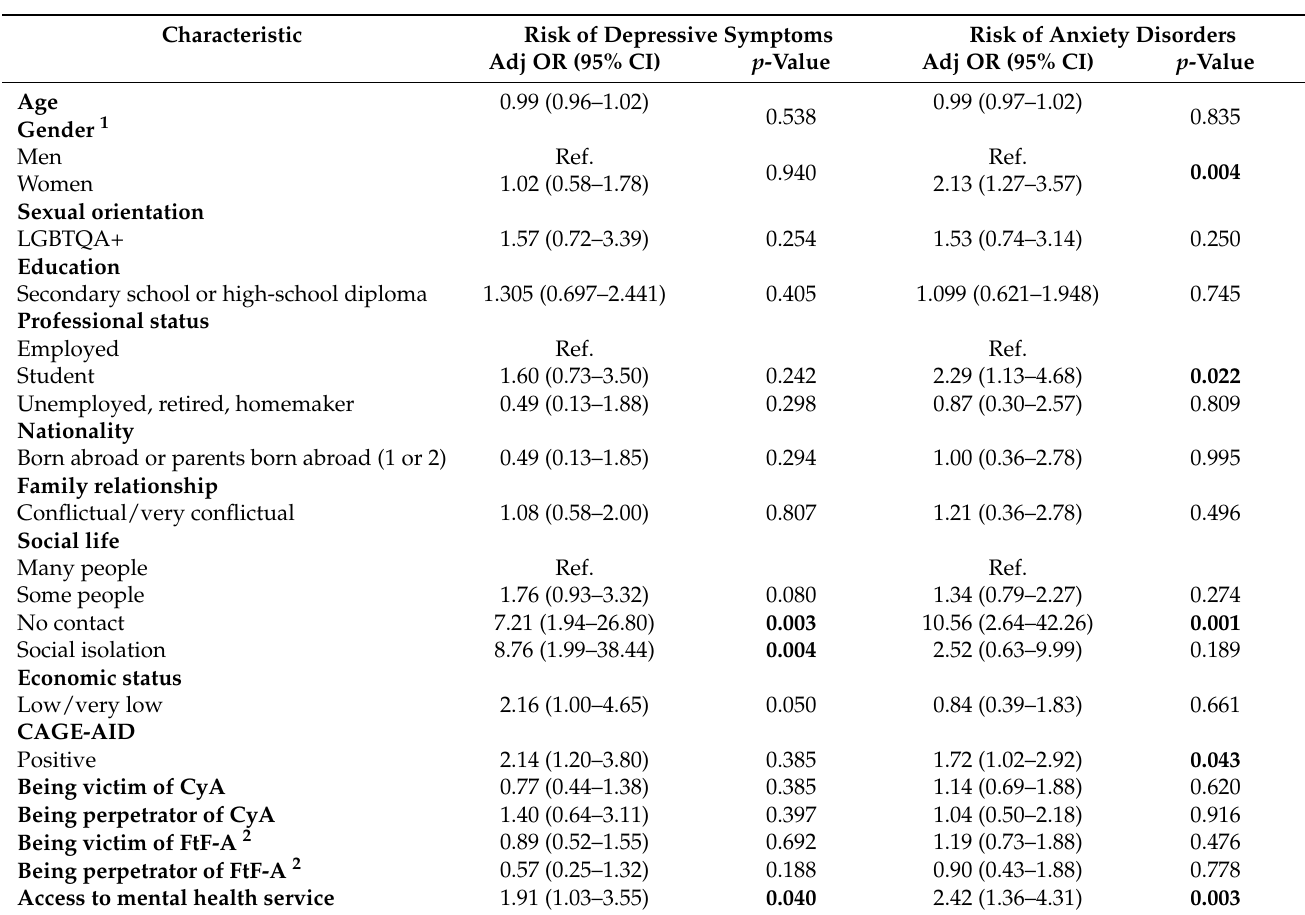
Table 4. Multivariable regressions models of secondary